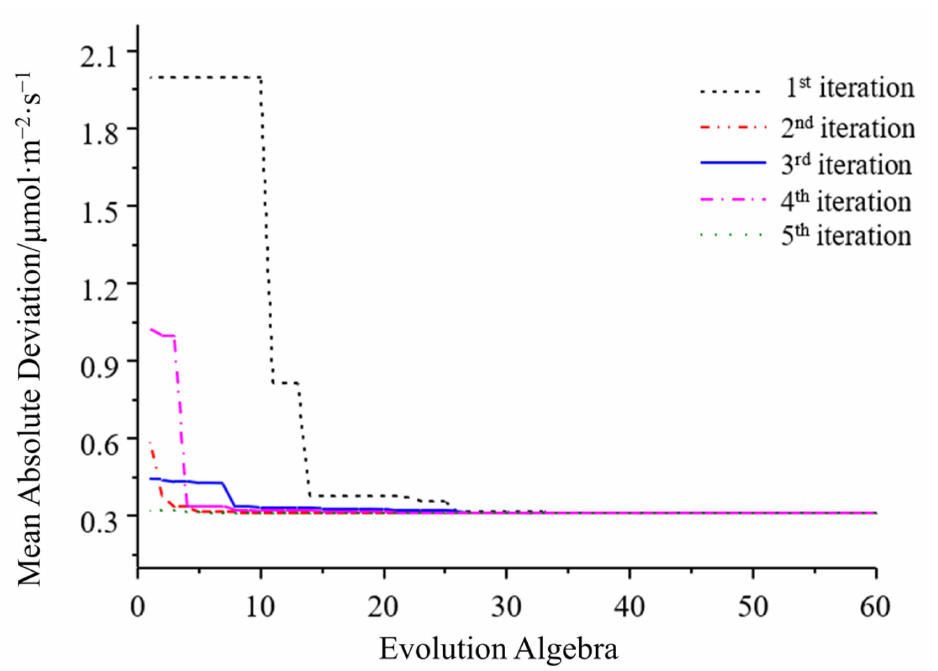
Figure 5. Multi-population genetic algorithm five evolution curves.